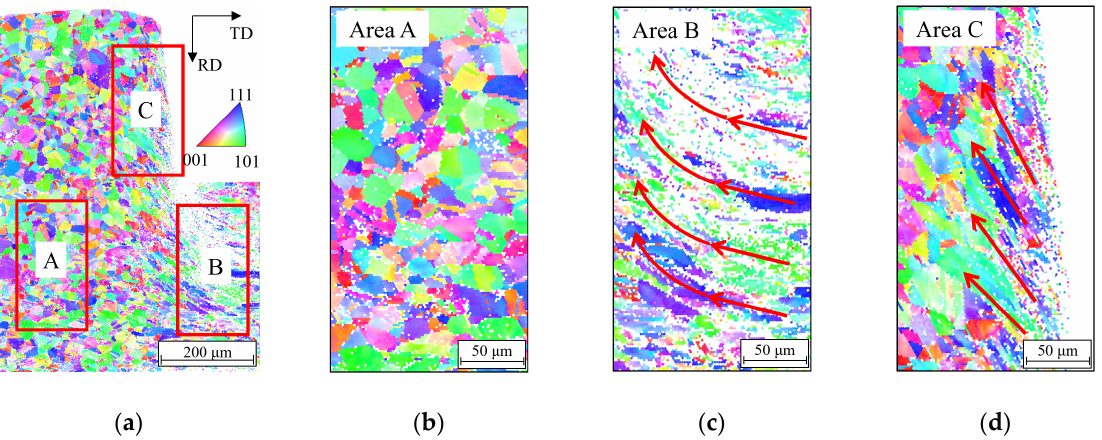
Figure 15. Microstructures of different regions: ( a ) Right region; ( b ) Area A; ( c ) Area B; ( d ) Area C.